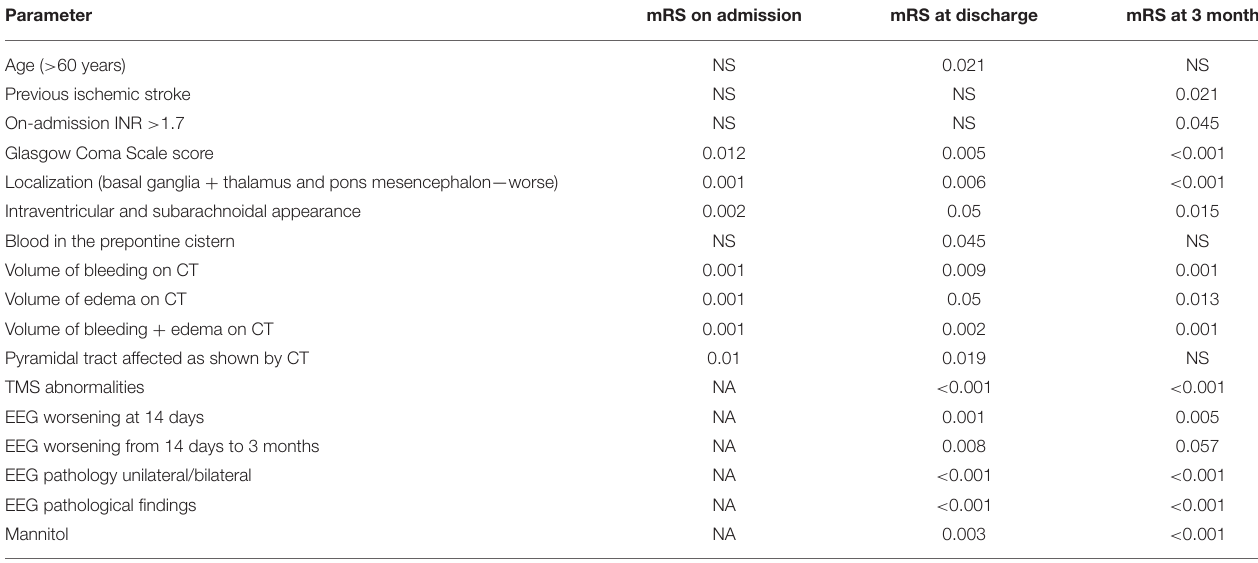
TABLE 5 | Predictors of on-admission disability (mRS) and outcome (mRS at discharge, mRS at 3 months) with univariate analysis [not significant (NS)], unless significant parameters are listed in at least one column.